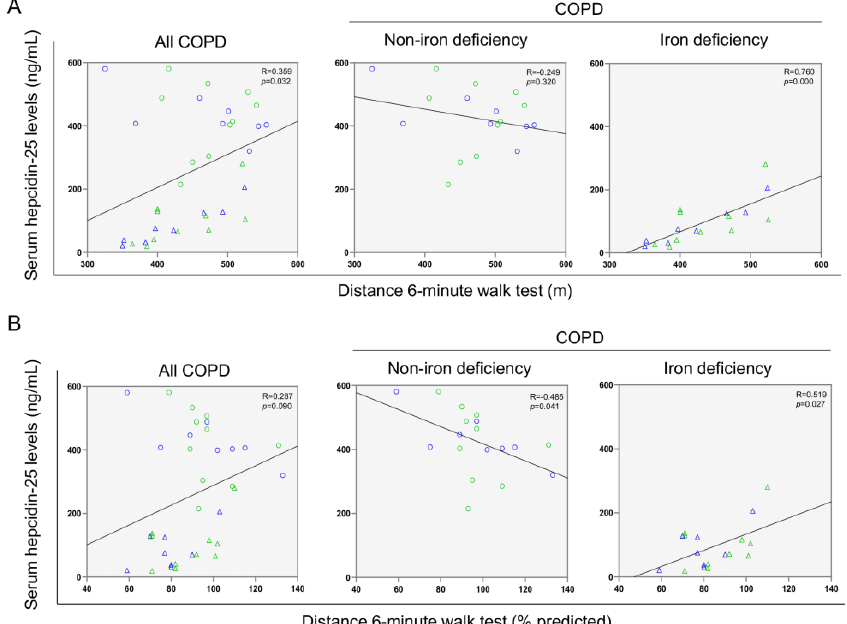
Figure 5. Scatter plots representation of correlations between serum hepcidin levels and distance six-minute walk test (m) ( A ) and distance six-minute walk test (% predicted) ( B ) in all COPD patients ( left panels), non-iron deficiency ( middle panels) and iron deficiency ( right panels) COPD patients. In the scatter plots, the green color dots or triangles indicate male patients in either study group, while the blue color dots or triangles indicate female patients in the same groups. Definition of abbreviations: COPD, chronic obstructive pulmonary disease.